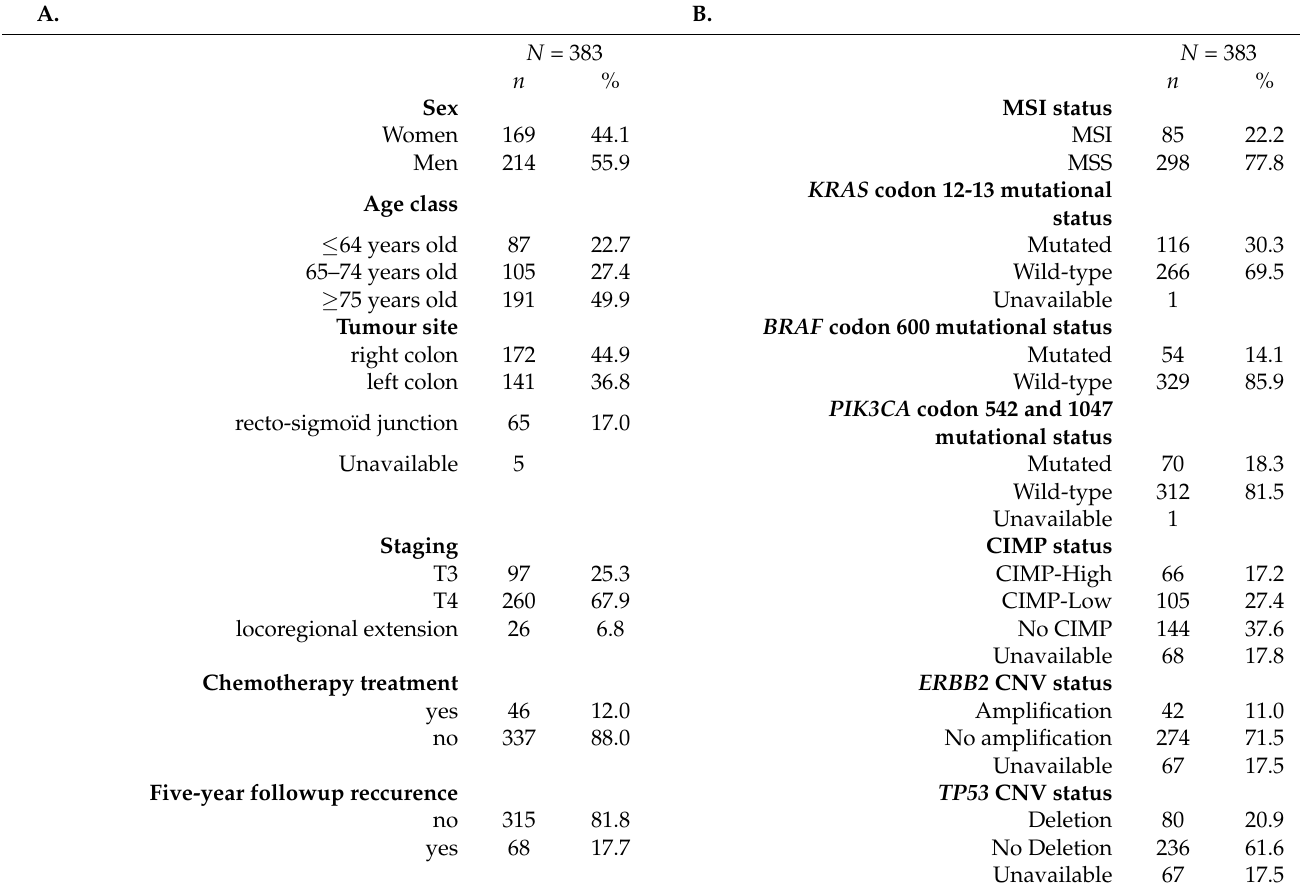
Table 1. Clinical and molecular characteristics of the stage II colon cancer population-based discovery